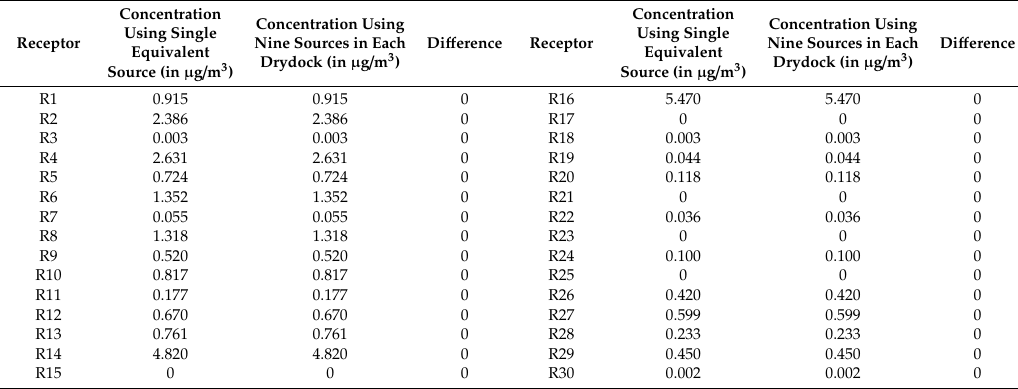
Figure 6. Source-receptor geometry for nine sources at each drydock and a total of 27 sources at the facility. Table 6. Comparison of calculated ambient